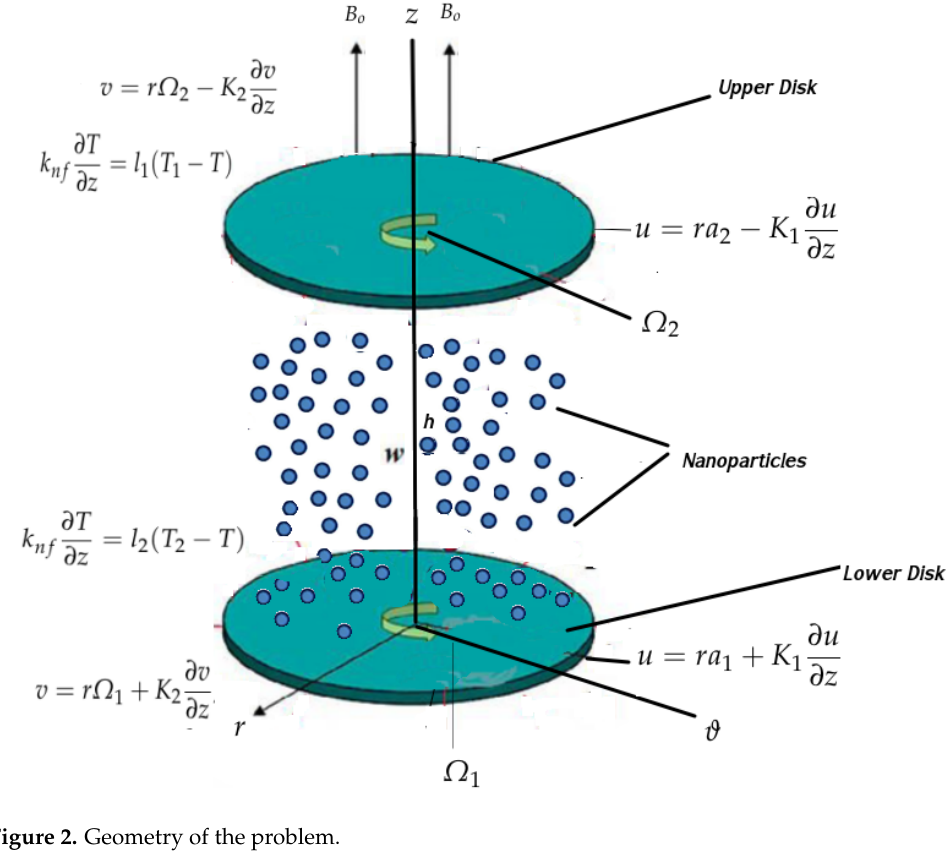
Figure 2. Geometry of the